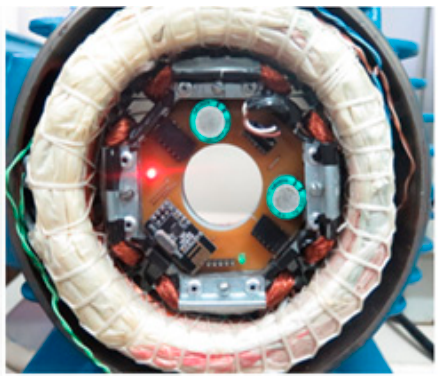
Figure 12. Voltage value generated after passing through the regulator.